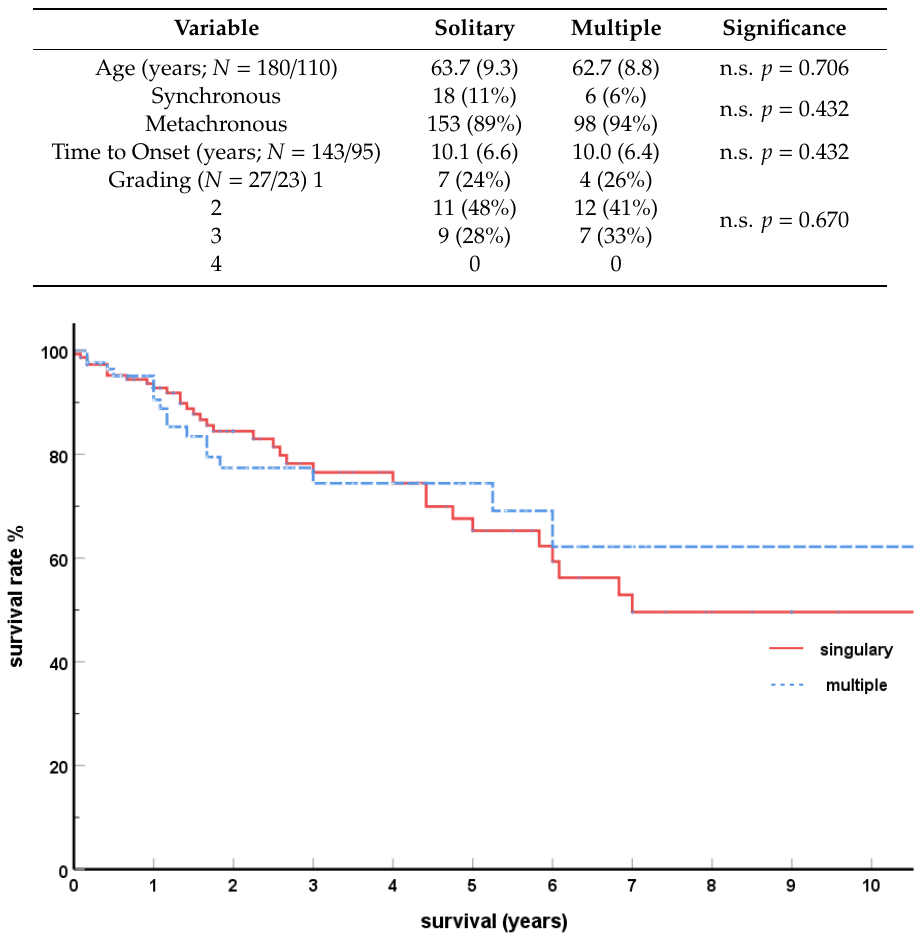
Figure 1. Kaplan–Meier survival curves; solitary versus multiple isolated pancreatic metastases from renal cell carcinoma ( p = 0.557).